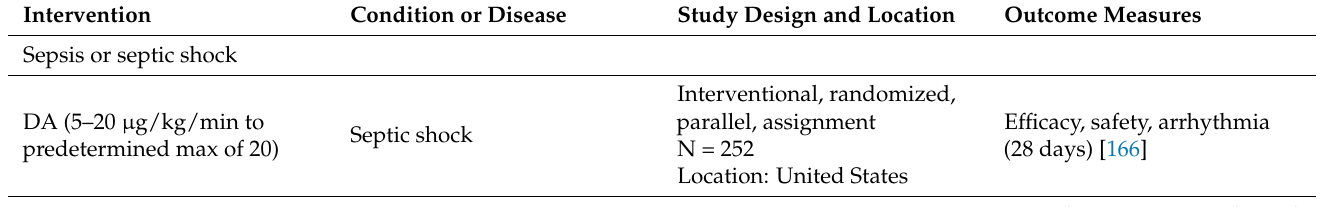
Table 2. Clinical trials where the effects of DA and DA agonists or derivatives are being studied in non-CNS diseases as possible drugs or